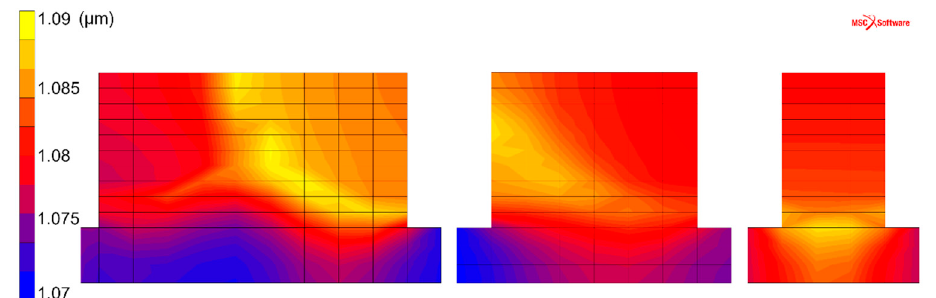
Figure 8. Simulated α lath thickness (µm), cross-sections with walls of widths of one, two, and three weld beads. Figure 9. Simulated α lath thickness (µm) variation in the additive manufactured part.